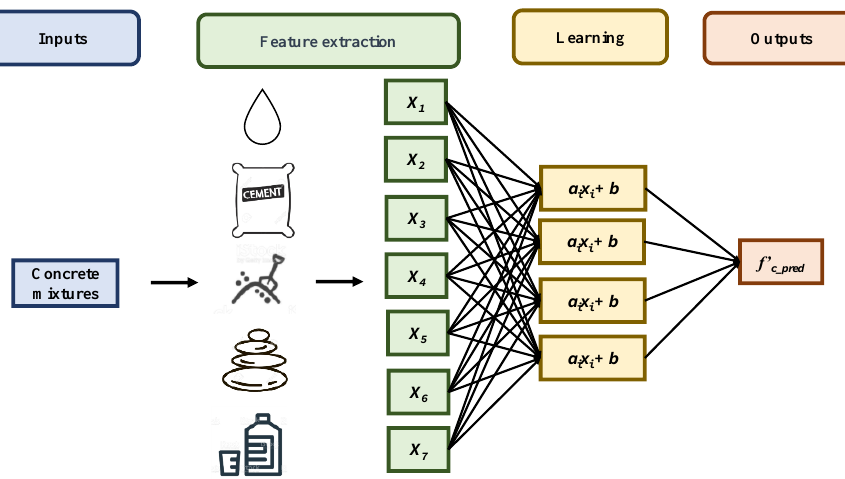
Figure 2. Interpretation of machine learning with concrete mixtures.